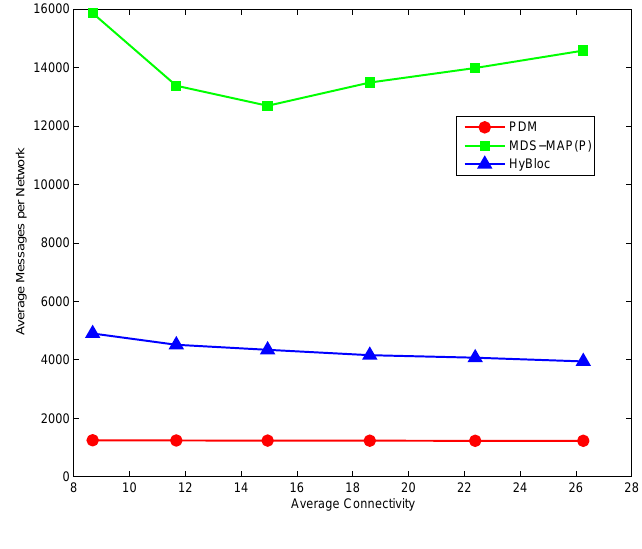
Figure 21 . Average number of messages transmitted per C-shaped